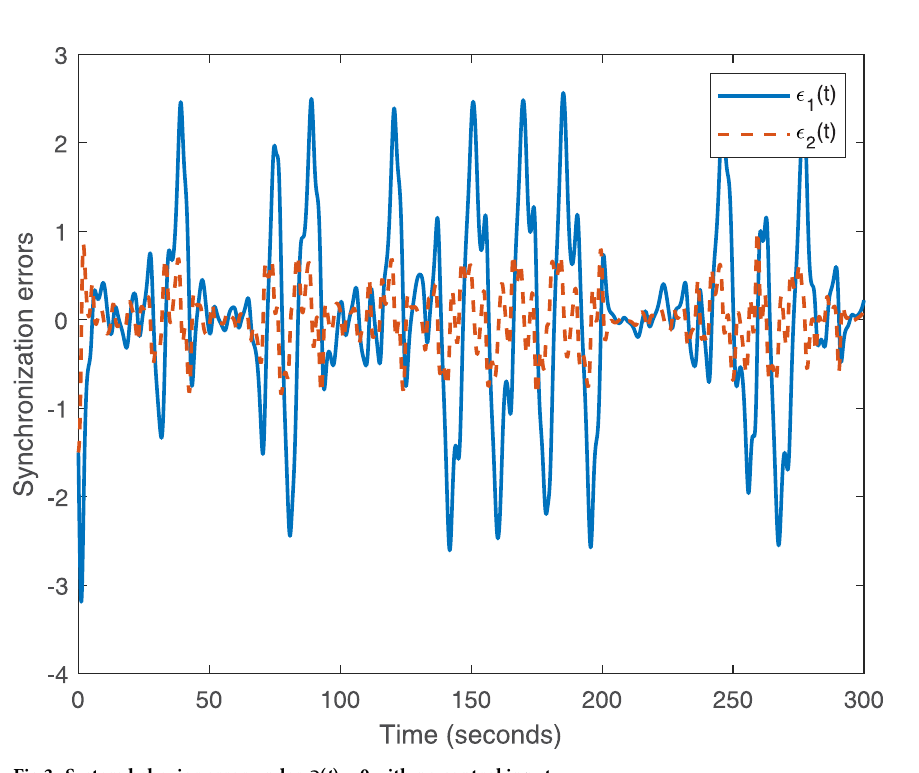
Fig 3. System behavior error under ϖ ( t ) = 0 with no control input.